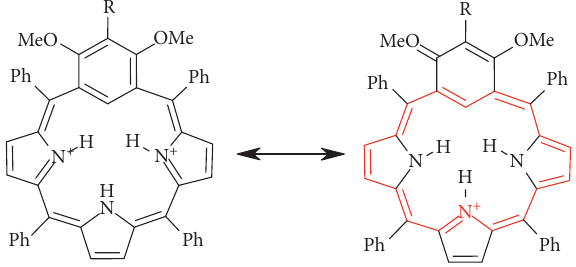
Figure 1: Chemical structure of methoxybenziporphyrin